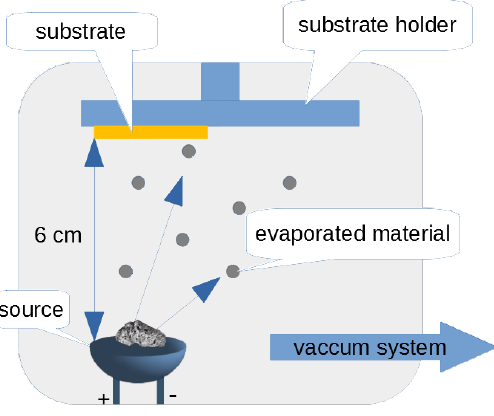
Figure 1. Schematic drawing of the physical vapor deposition (PVD) process, thermal evaporation technique.